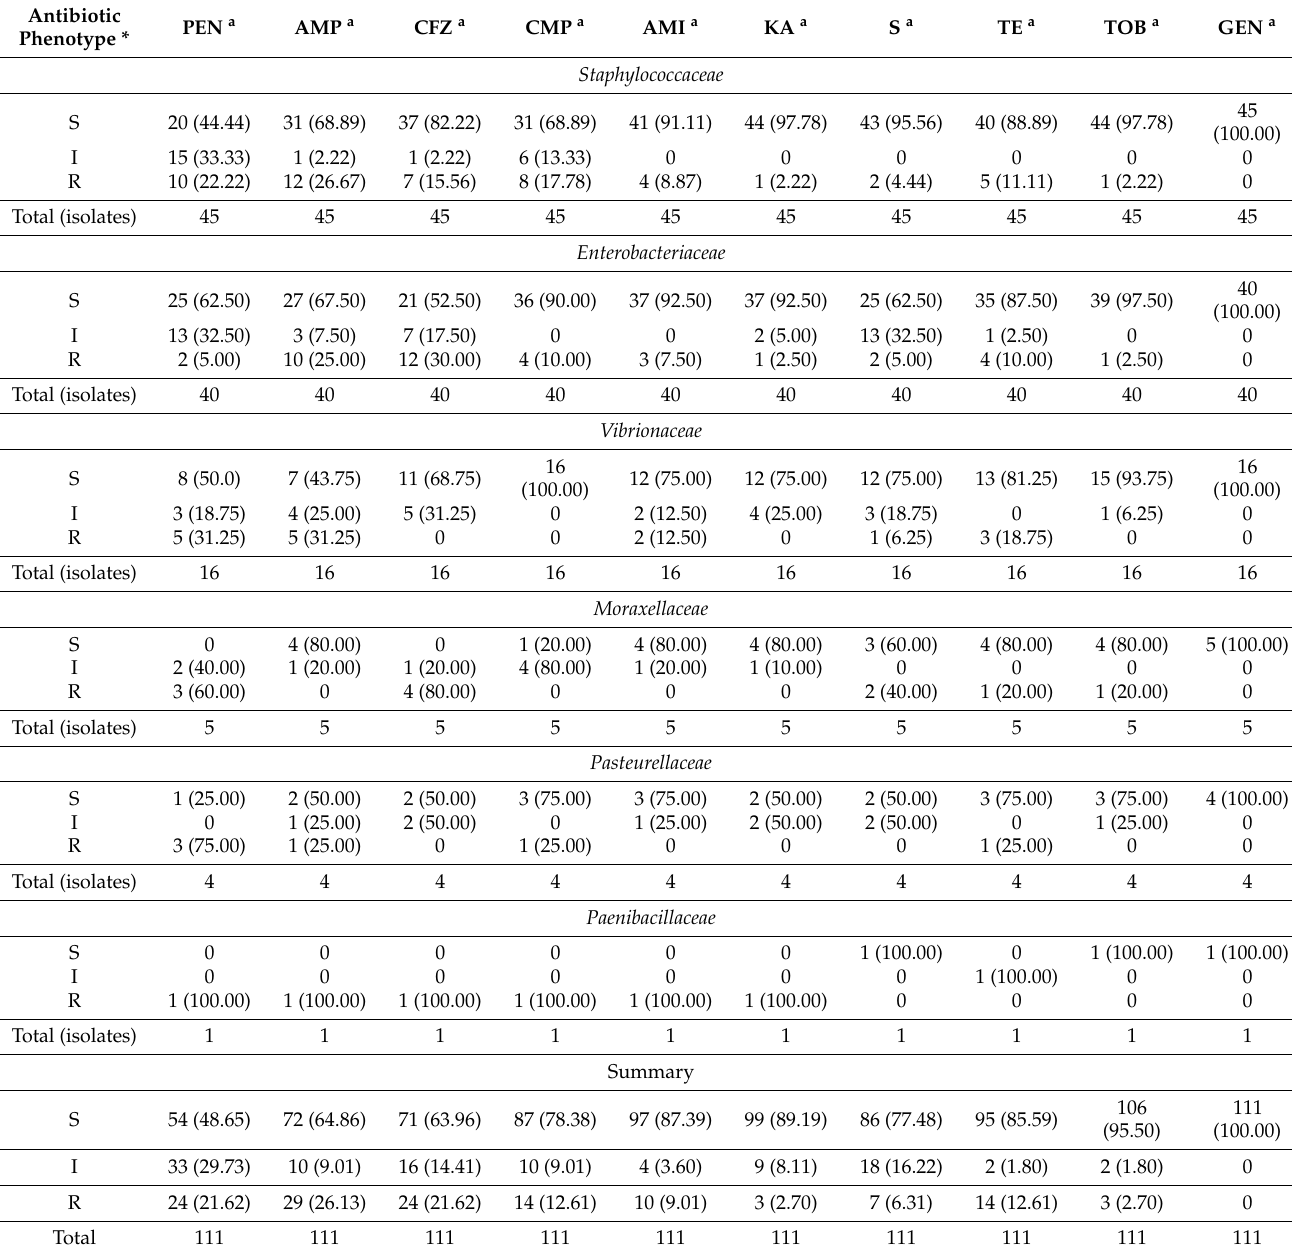
Table 2. Antibiotic susceptibility of one hundred and eleven isolates from turtle rearing seawater at STCCT during the periods 2015 to 2016, 2018, and 2019. The number in parentheses indicates percentages of